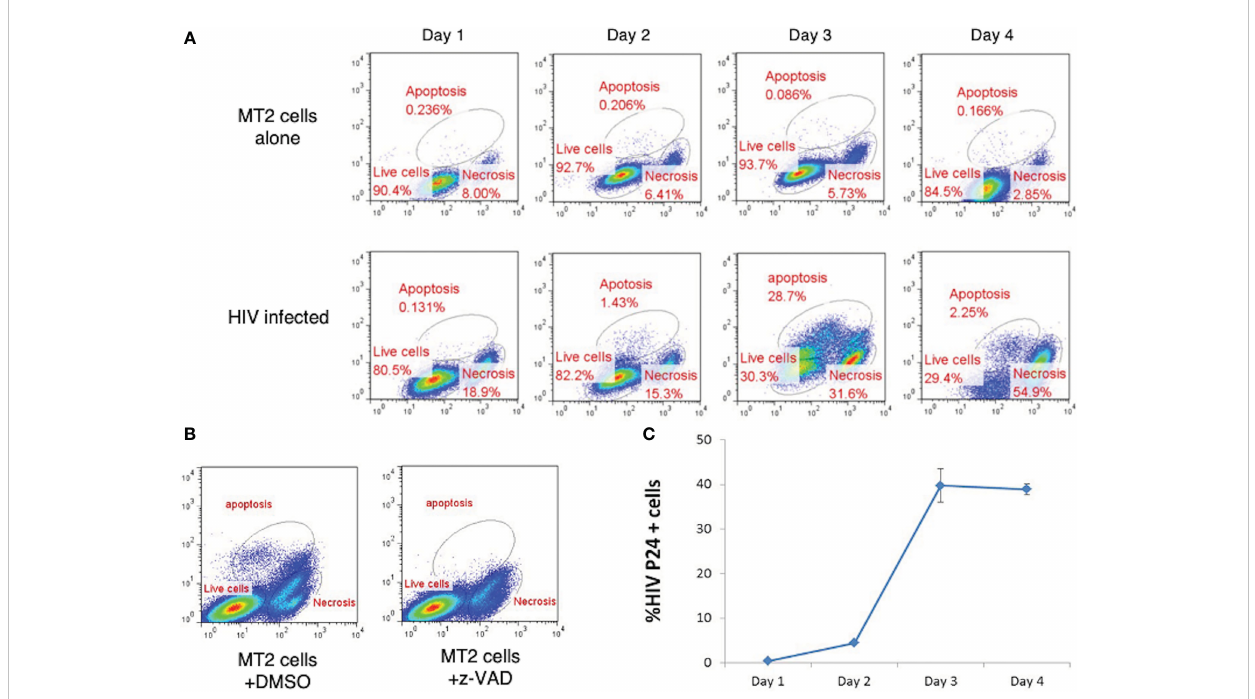
FIGURE 2 Effect of HIV Infection on Cell Death in MT2 Cells. (A) HIV infection led to cell death by apoptosis and necrosis. MT2 cells were infected at day 0 with HIV IIIB (MOI 0.001). Cell death was determined by live-dead dye (X-axis) vs. Caspase-3 (Y-axis) double staining and measured over four days by fl ow cytometry. (B) Flow cytometry dot plots show apoptosis of MT2 cells was inhibited with the presence of z-VAD (10 µM) left overnight but not DMSO. (C) . HIV p24 detected by PE-labeled anti-p24 antibody was used to measure the percentage of MT2 cells infected with HIV IIIB (MOI 0.001) over 4 days. Data shown as mean ± SD. These data are representative of three independent